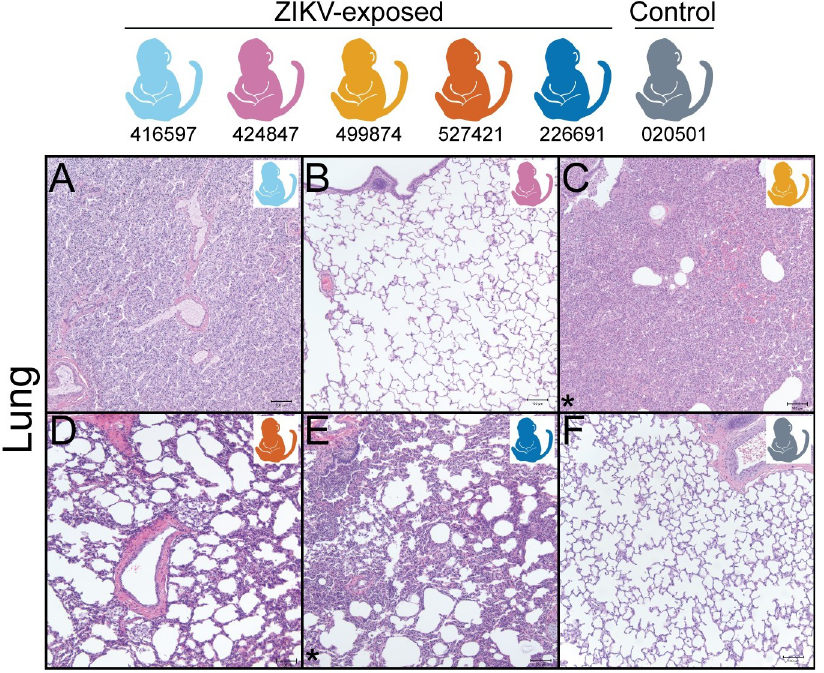
Fig 13. Fetus/Infant tissue histopathology of the lung. (A-F) Diffuse bronchopneumonia is present in 2 of 5 ZIKV- exposed infants (C, E) but not in a control infant (F) or 3 of the ZIKV-exposed infants (A, B, D) (images with bronchopneumonia are denoted with an asterisk). The lung in the stillborn macaque (A) is atelectatic (uninflated) due to stillbirth. Macaque colors represent individual animals as depicted at the top of the figure. Scale bar is 100 μ m.